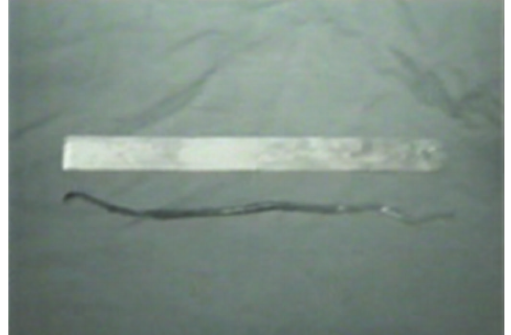
Figure 5: Ascaris